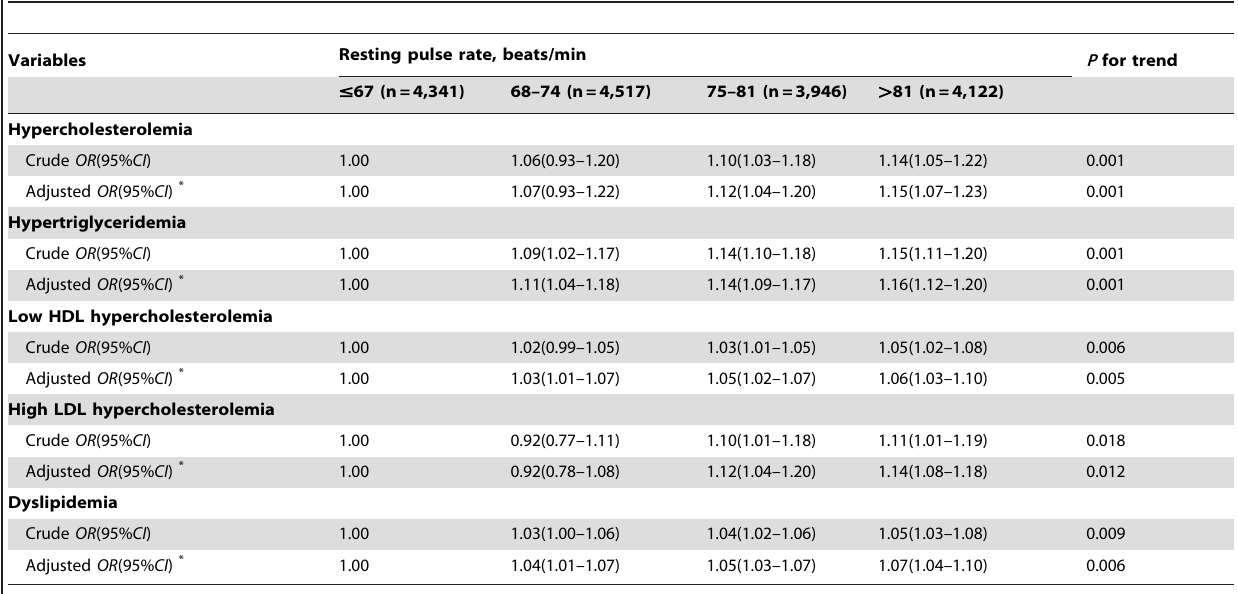
Table 2. Odds ratios and 95% confidence intervals of lipid metabolic dysfunctions according to quartiles of resting pulse rate